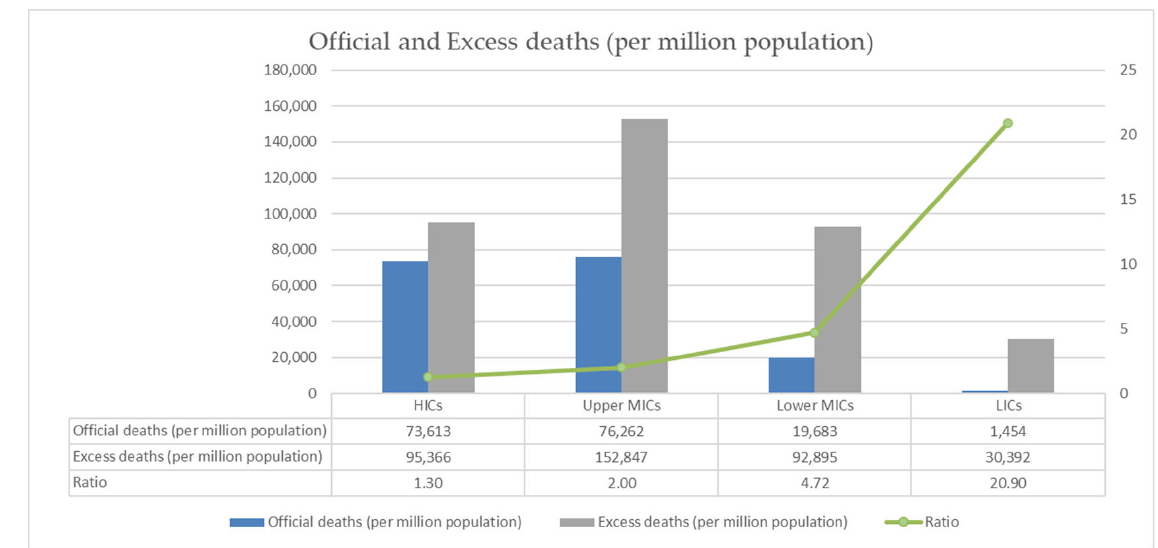
Figure 2. Global estimates of the mortality burden of COVID ‐ 19 as of 1 December 2021. Table 1. Global estimates of the mortality burden of COVID ‐ 19 as of 1 December 2021.